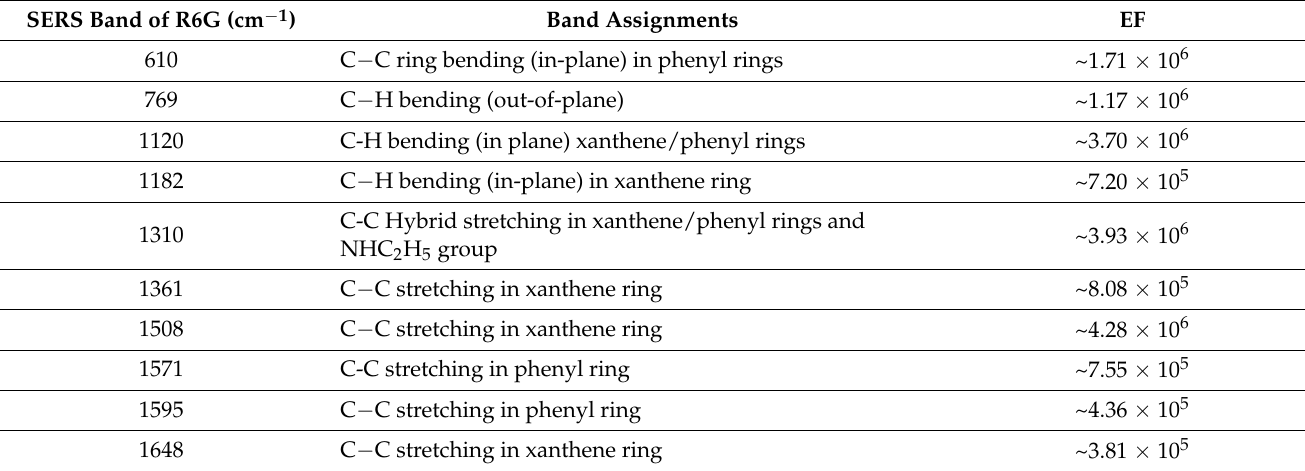
Figure 4. ( a ) SERS spectrum of R6G adsorbed on Ag-NPs-decorated Si-NSs; inset: Magnified view of the spectrum marked by a black dashed rectangle therein. Vertical dotted red lines in the inset represent SERS bands of R6G. ( b ) Bright-field microscopic image of the same indicating the spot of interest in acquiring SERS spectrum marked as the white “x” therein, ( c ) Raman spectrum of R6G adsorbed on as-fabricated Si-NSs and ( d ) Zoom-in view of a small area of interest as marked by a black dashed square in ( c ). Four typical sites of diffraction limited Ag-NPs decoration are marked by 1, 2, 3 and 4 in ( d ). Table 1. SERS bands of R6G, corresponding band assignments, and estimated EF for individual bands in the presence of Ag-NPs-decorated